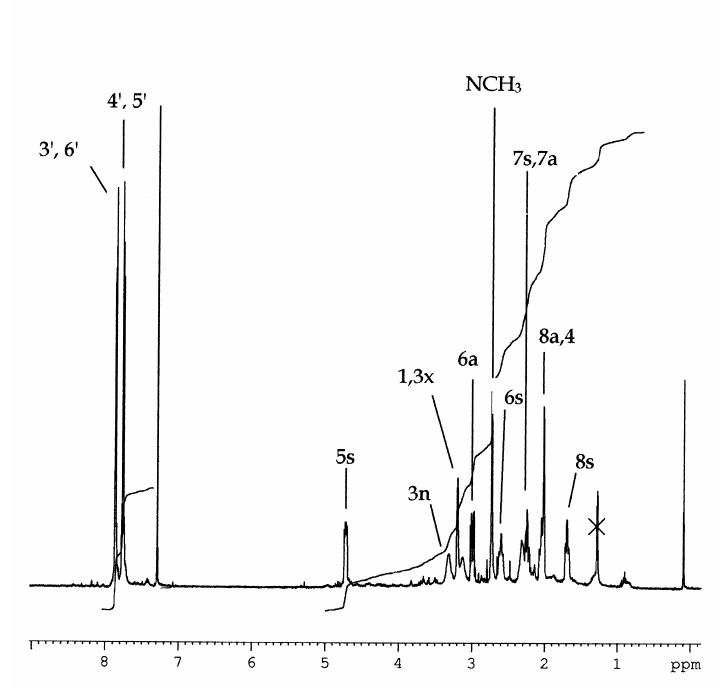
Fig. 5 1 H-NMR spectrum and assignment of compound 8 .